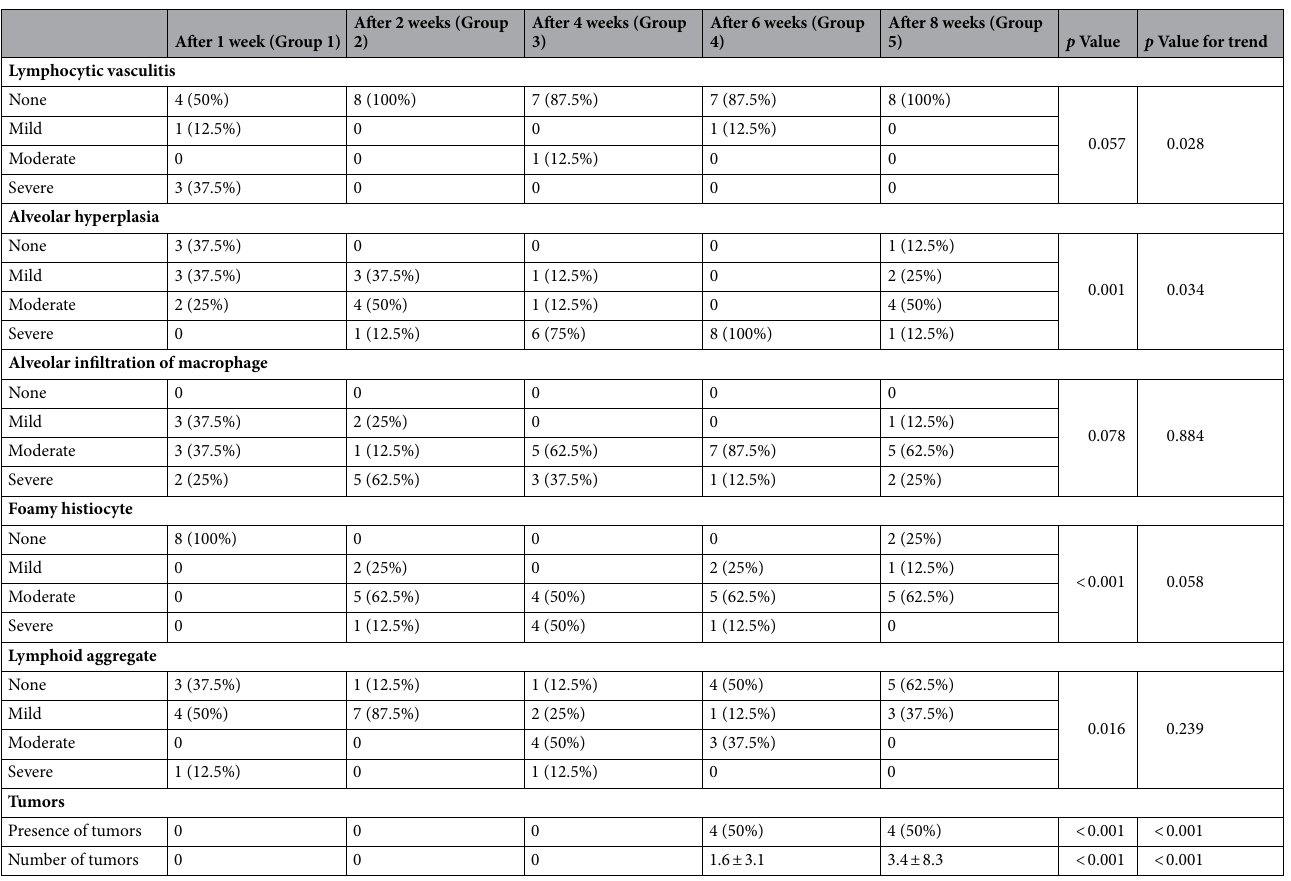
Table 3. The changes of pathologic findings according to the